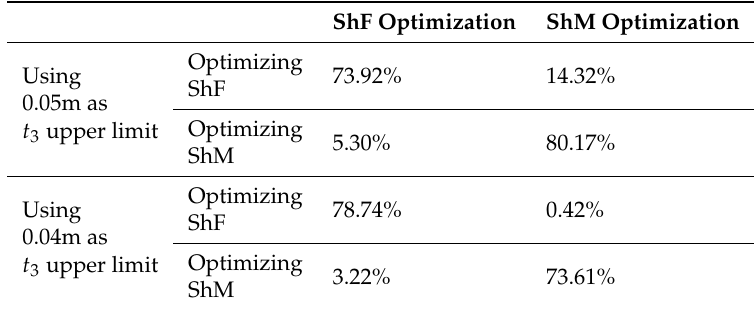
Table 3. Comparison between optimization results when expanding the thickness upper limit of